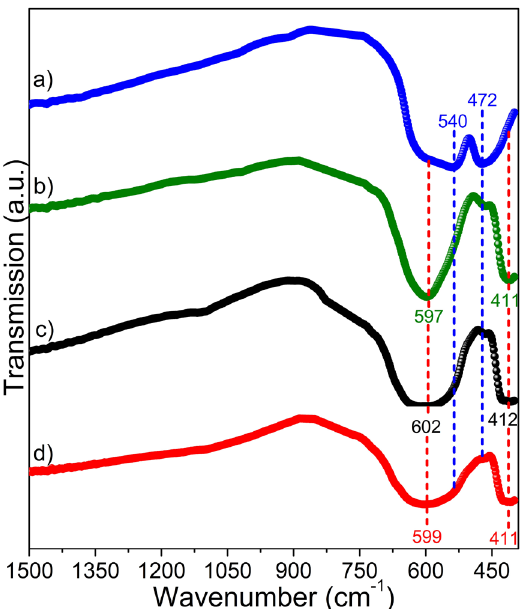
Figure 4. IR spectra of (a) the initial mixture of reactants and of the samples submitted to heat treatments at (b) 1000 ºC, (c) 1100 ºC and (d) 1200 ºC. The positions of the IR bands related to α-Fe NiO and NiFe O are indicated in the 2 4